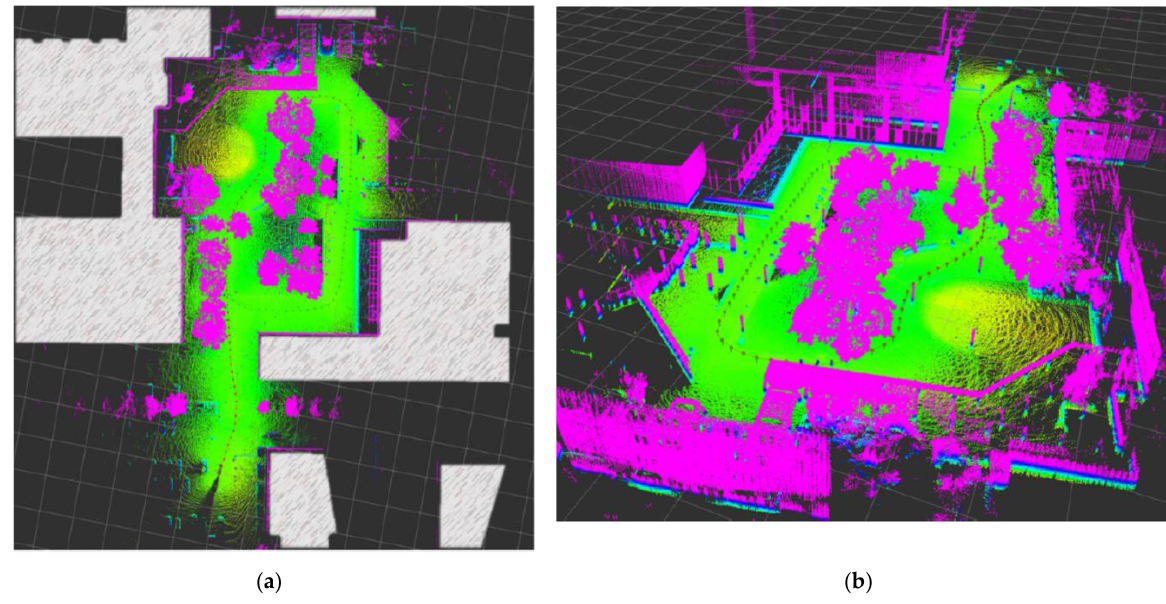
Figure 15. ( a ) Comparison of the map created using hdl_graph_slam (FAST_GICP) with the map of the Geoportal BW. ( b ) Map of the Offenburg campus created with hdl_graph_slam (FAST_GICP). Incline The last test scenario checks how well hdl_graph_slam detects gradients. For this purpose, two test scenarios are considered, in which the scan matching algorithms FAST_GICP and FAST_VGICP are used. In addition, the tests are performed once with and once without a floor_detection node.